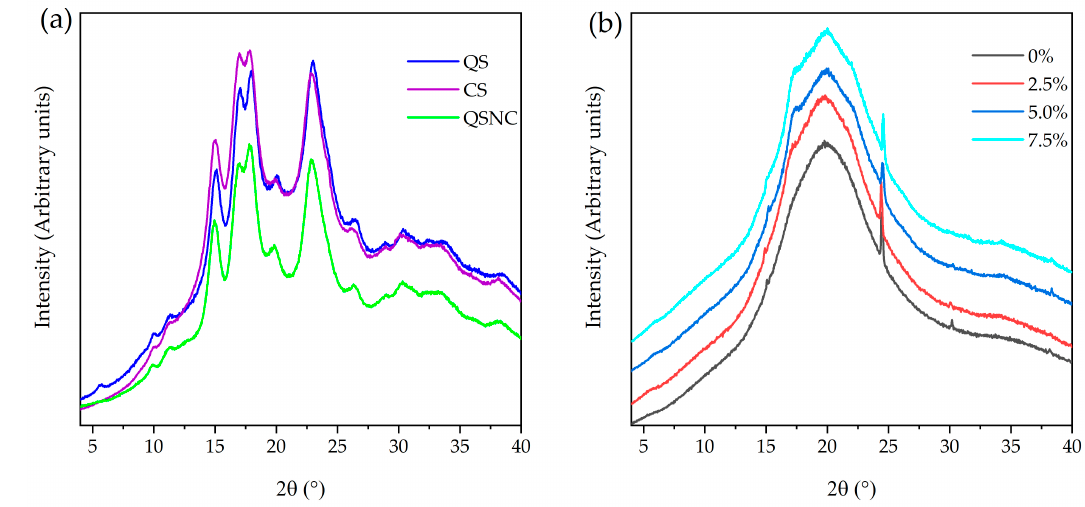
Figure 2. X-ray diffraction patterns: ( a ) of quinoa (QS) and cassava (CS) starches and quinoa starch nanocrystals (QSNC), and ( b ) of cassava starch films containing quinoa starch nanocrystals at different concentrations.